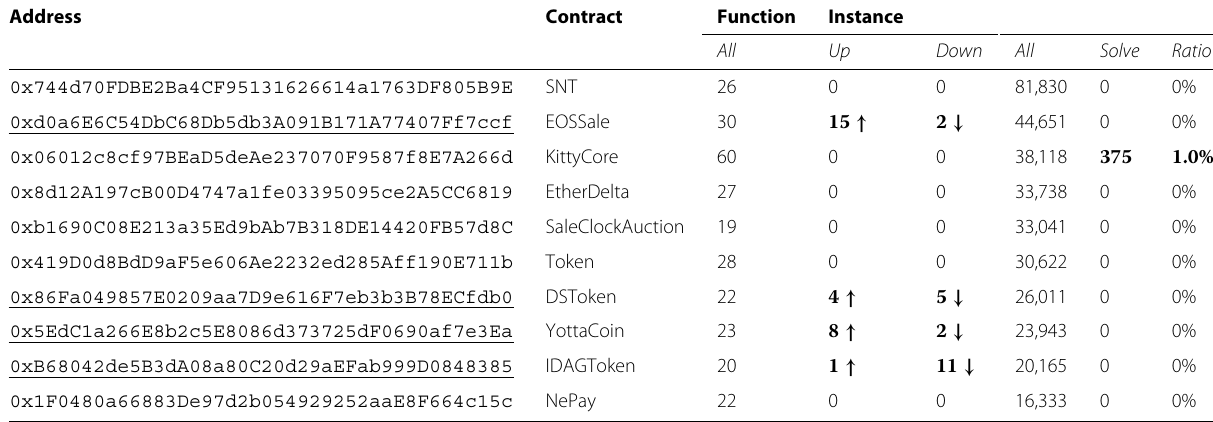
Table 8 solc built-in code optimizer in use of preventing out of gas exceptions, with -optimize option turned on and the -optimize-runs parameter set to